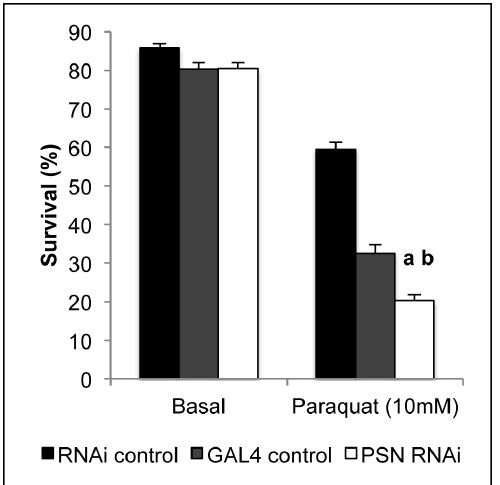
Figure 6. Oxidative stress tolerance in Drosophila . Paraquat, a potent inducer of superoxide, was used to assess oxidative stress tolerance. Survival to adulthood was assessed on basal media and media supplemented with 10 mM paraquat for control (RNAi control, GAL4 control) and midgut PSN knockdown (PSN RNAi) Drosophila . Values are percentage survival with S.E.M. from fifteen replicates of 50 Drosophila . PSN knockdown Drosophila were more susceptible to paraquat-supplemented media, indicative of greater sensitivity to superoxide. a Significant difference from RNAi control, b significant difference from GAL4 control, as determined by two-way ANOVA with Tukey’s post-hoc test (P , 0.001).